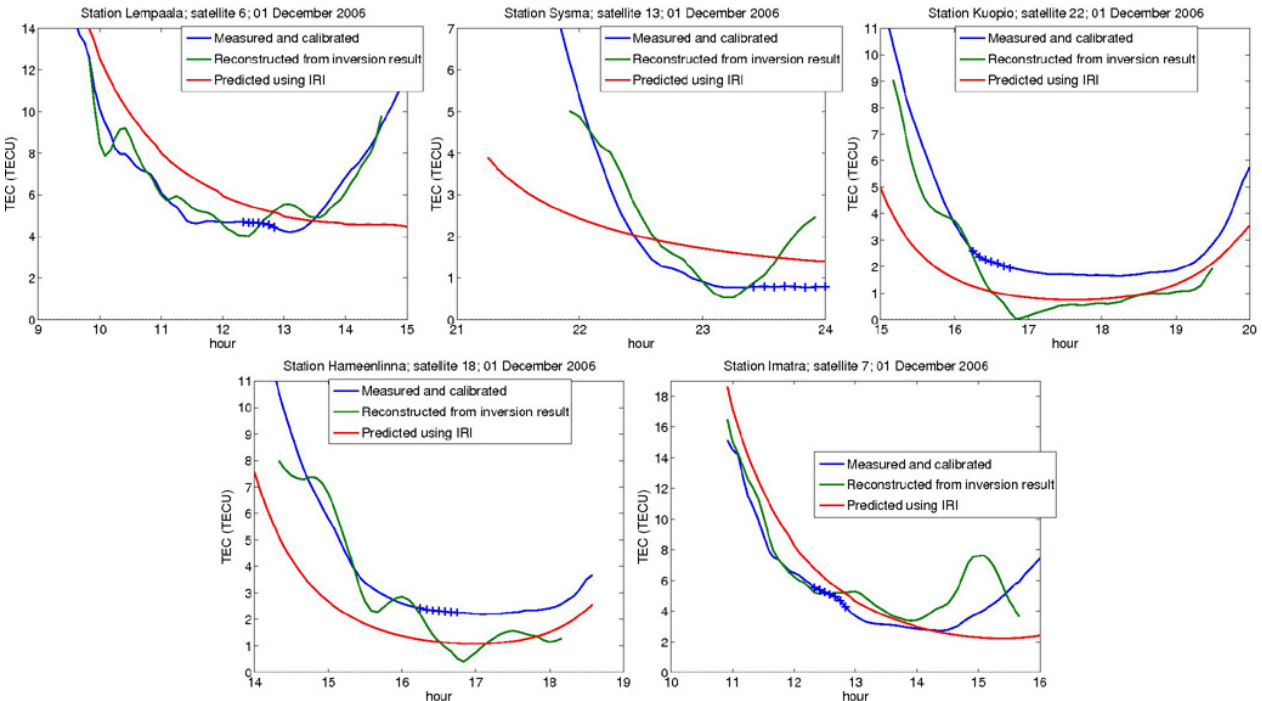
Fig. 7. Calibrated TEC measurements of several receivers and satellites on 1 December (blue curves). The samples at which calibration was performed are indicated as “ + ”. Also included: the inversion results integrated for the same satellite-receiver paths (green curves), and the TEC along the same paths according to the IRI model for the same date and time (red curves).